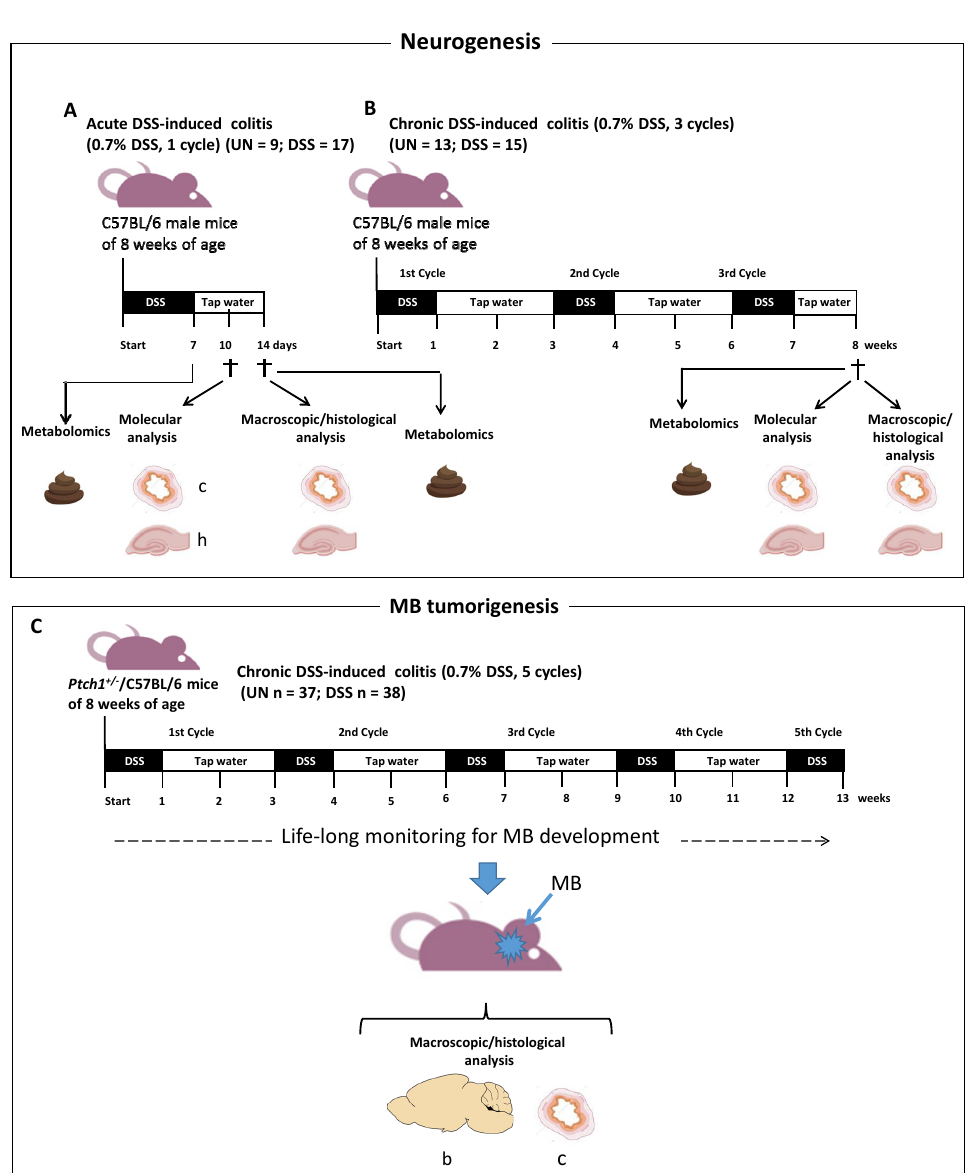
Figure 1. Treatment schemes, size of the groups and endpoints. UN: untreated group. DSS: sodium dextran sulfate-induced colitis group. ( A ) Induction of acute DSS-induced colitis ( B ) Induction of chronic DSS colitis. ( C ) Extended chronic DSS-induced colitis for tumorigenesis. †—time points of sacrifice, C–colon, h–hippocampus, b–brain, s–stool. The number of mice used for each analysis is indicated in the corresponding sections (n).